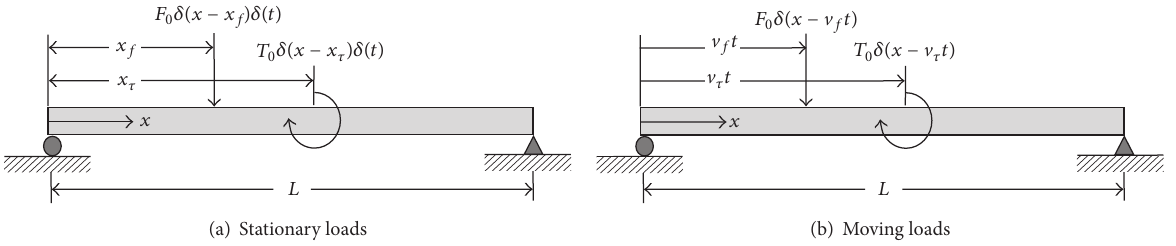
Figure 1: A simply supported Timoshenko beam subjected to (a) a stationary impulsive point transverse force and a stationary impulsive point bending moment and (b) a moving point transverse force and a moving point bending